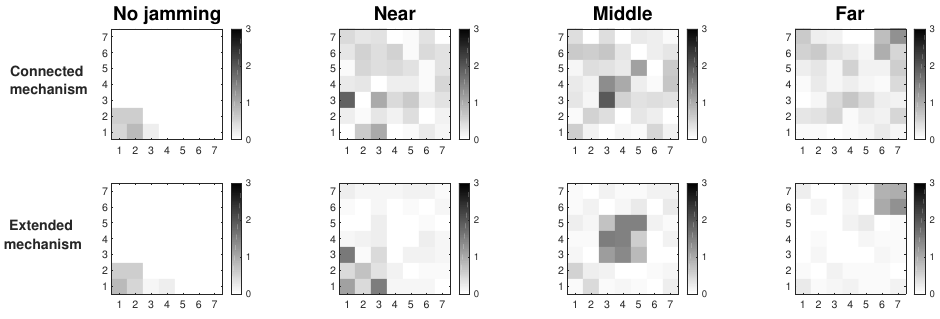
Figure 3. Connected vs extended mechanisms over MPH protocol under the Scenario 3.